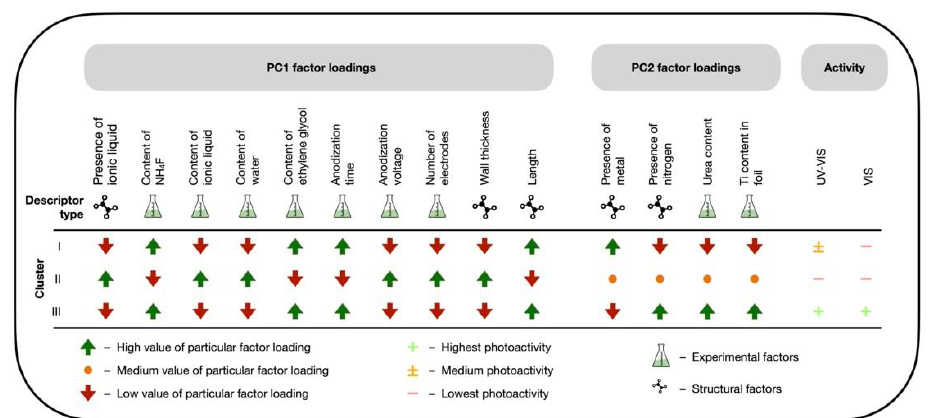
Figure 4. The graphical interpretation of the finding from PCA analysis that presents the relationship between experimental conditions, structural features, and photocatalytic efficiency.